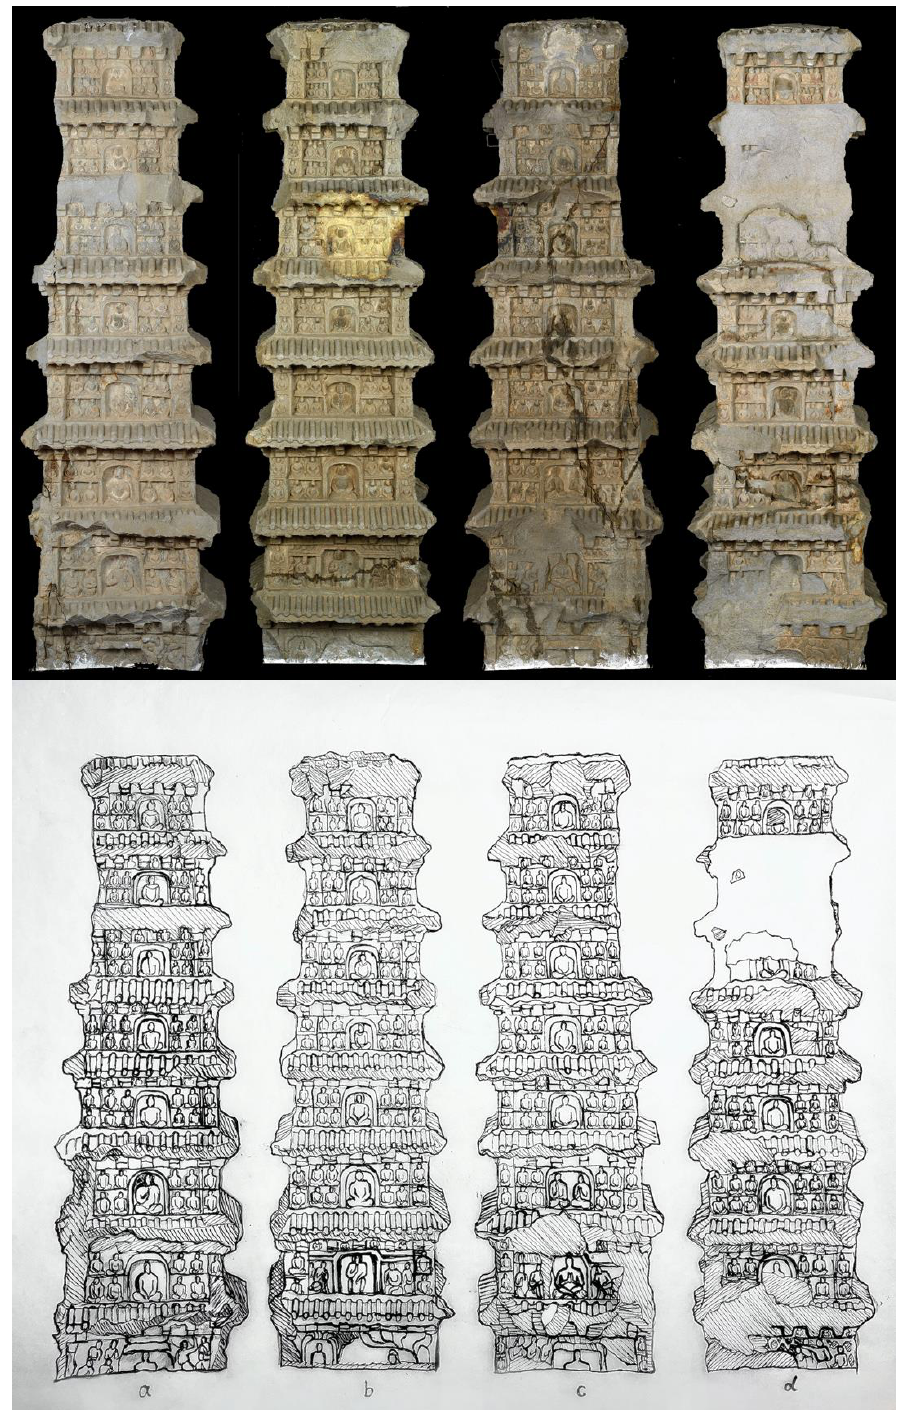
Figure 12. ( a–d ) Daiwangcheng 代 王 城 Pagoda, late fifth century, Northern Wei. (Yuxian 蔚 县 , Hebei province. Stone. H. 150 cm, W. (base) 37.5 cm. Daiwangcheng Museum. Photograph courtesy of Zhang Jianyu. Diagram by the author).